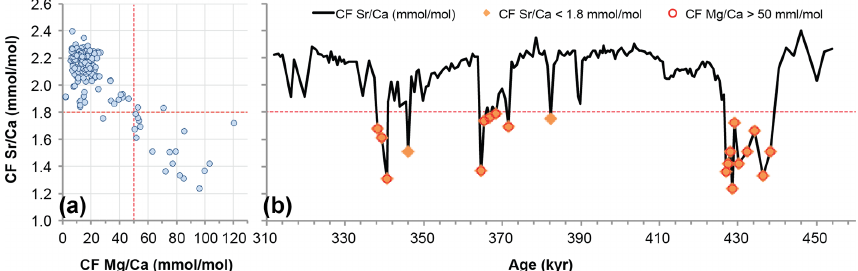
Figure 5. Detrital carbonate analysis: (a) coccolith fraction (CF) Sr / Ca results and CF Mg / Ca cross-plot (vertical red line delimits threshold at 30mmol/mol of Mg / Ca); (b) CF Sr / Ca samples possibly contaminated with detrital carbonate (red makers) and notably associated millennial abrupt events.